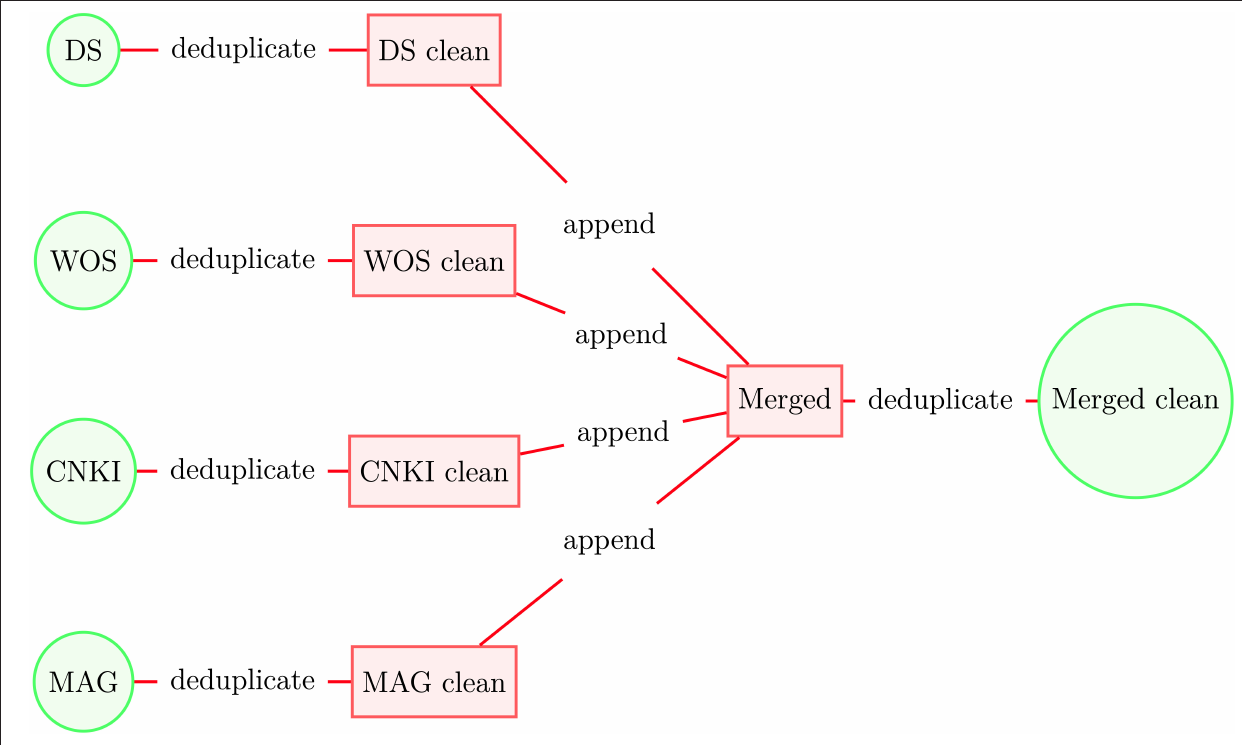
FIGURE 3 | Construction of merged academic dataset.